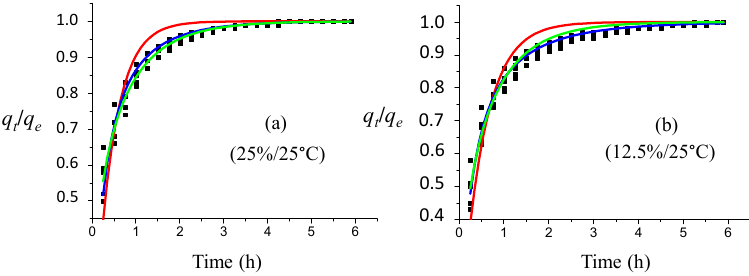
Figure 11. Experimental and fitted kinetics data at two different ammonia concentrations (GAC ‐ 5; 3.2 g/20 mL NH 3 solution). Red: pseudo ‐ first order (PFO); green: modified pseudo ‐ n order (MPnO) and blue: mixed order (MOE) (6.25%/25 °C; see Figure 13).